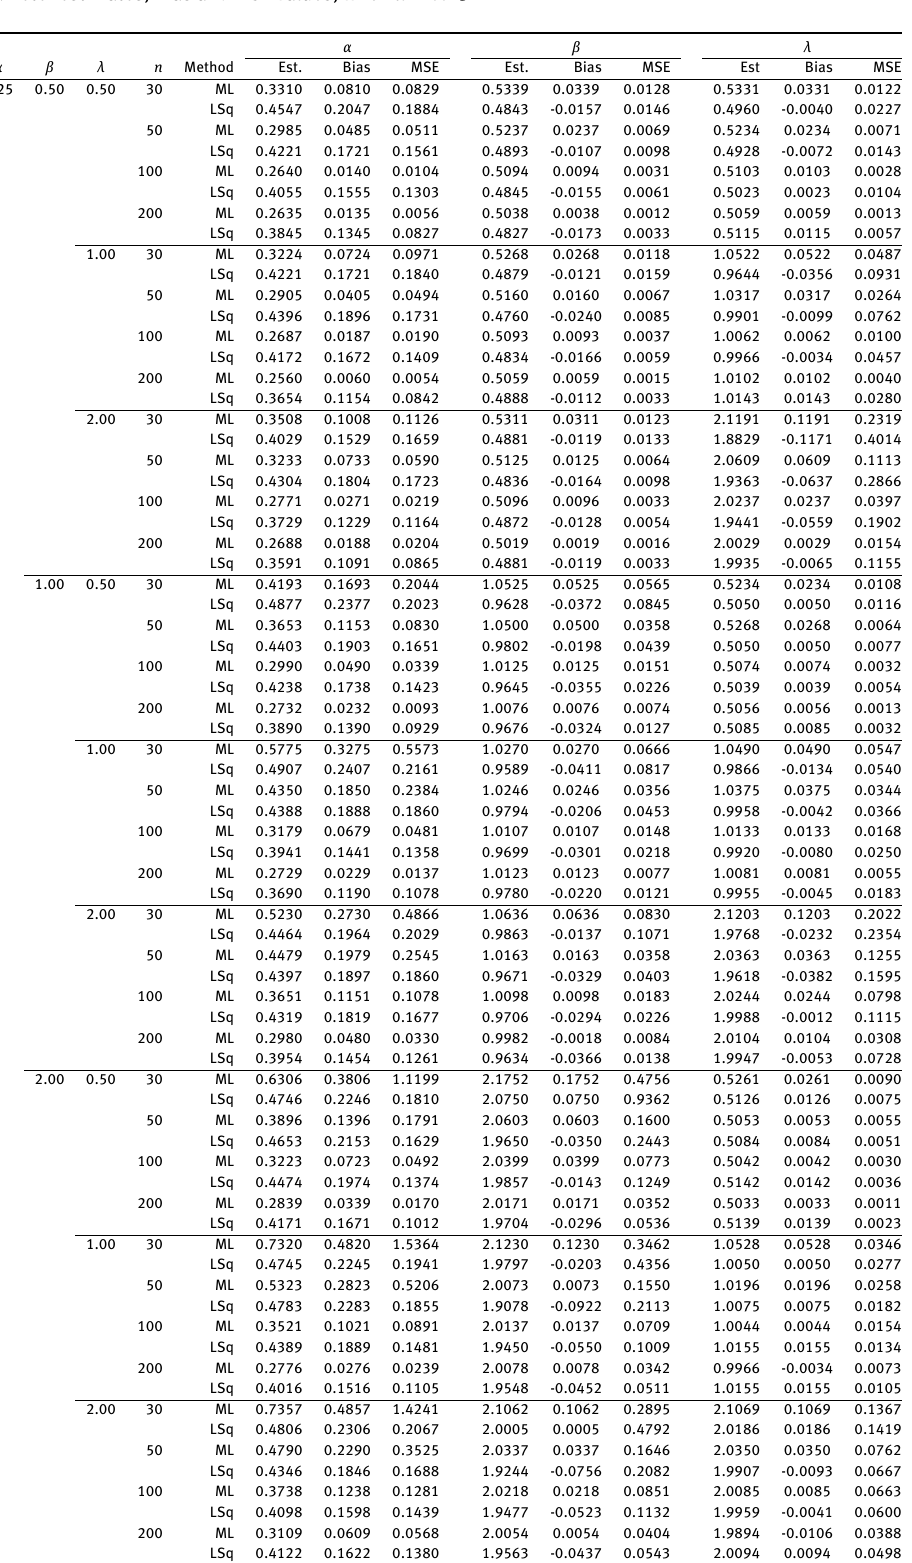
Table 1: Parameter estimates, Bias and MSE values, when α =